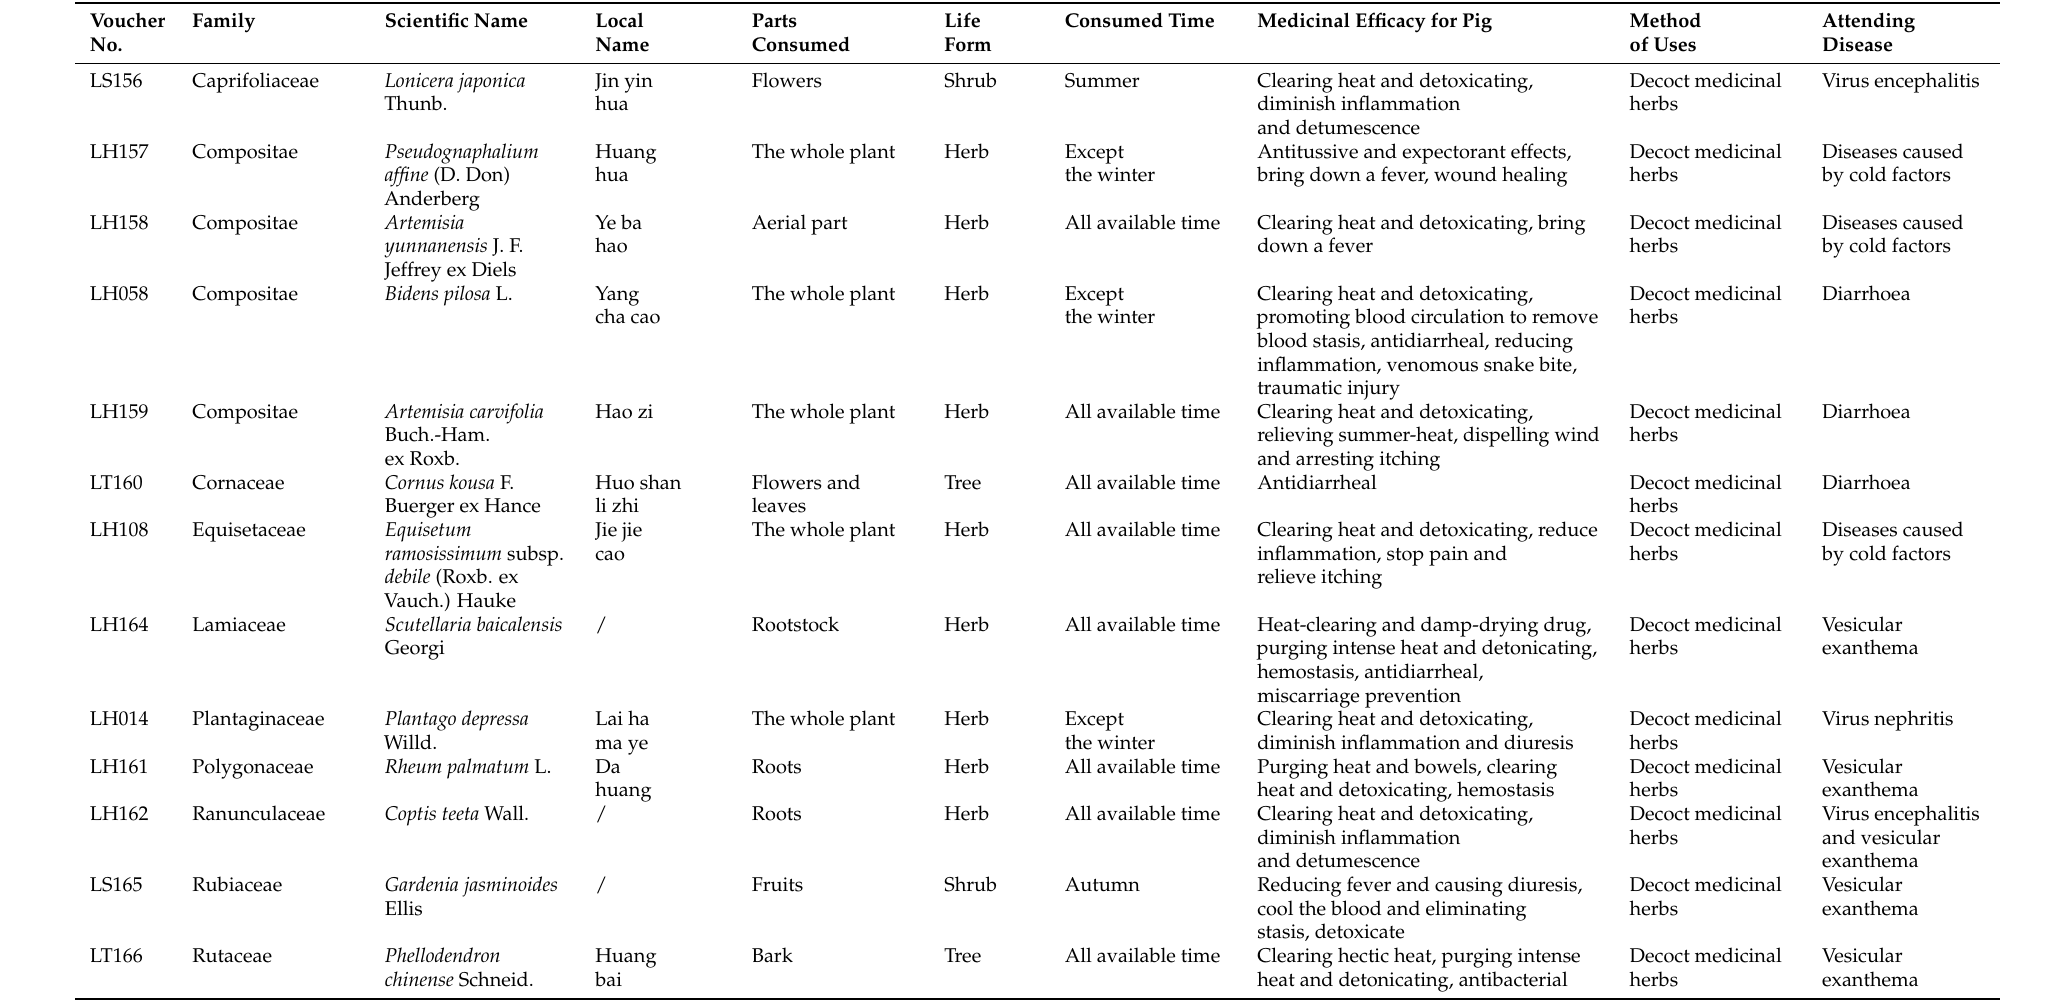
Table 5. Selected medicinal plants used for treating Gaoligongshan pigs’ common